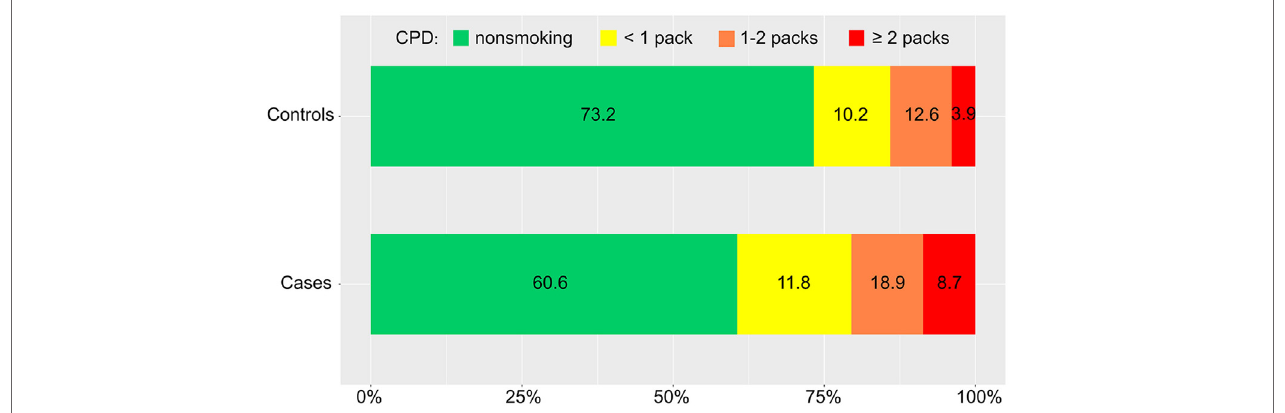
FigUre 2 | Distribution of daily cigarette intake in cases and controls. CPD, number of cigarettes smoked per